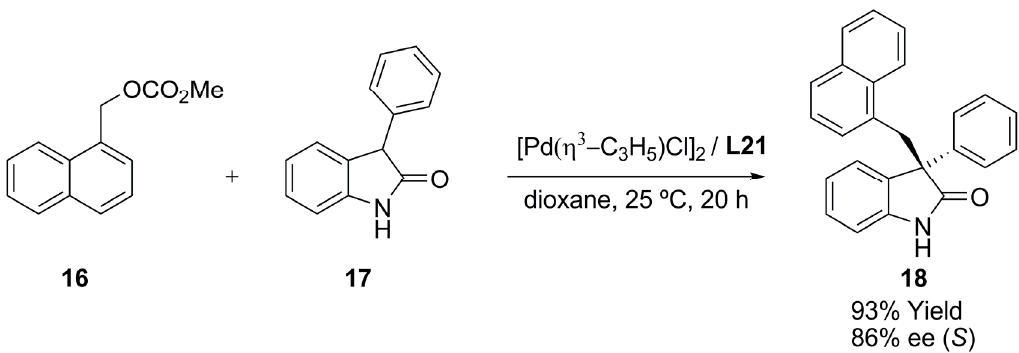
Scheme 7. Asymmetric benzylic alkylation